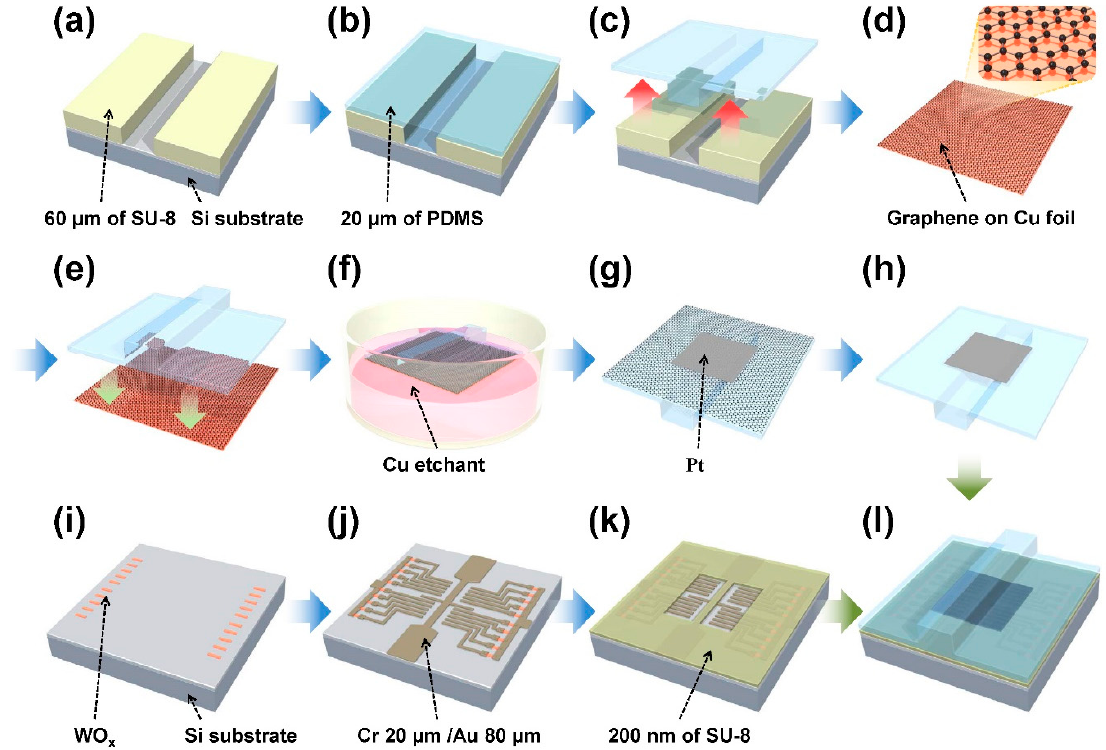
Figure 2. The fabrication process of the tactile shear sensor: ( a ) forming the SU-8 master for the top ridge structure; ( b ) polydimethylsiloxane (PDMS) molding and curing; ( c ) peel-off; ( d ) graphene growth; ( e ) pressing PDMS to graphene; ( f ) Cu foil etching; ( g ) Pt deposition; ( h ) graphene etching; ( i ) resistor formation; ( j ) electrode deposition; ( k ) spacer formation; ( l ) combining the top layer with the bottom substrate.